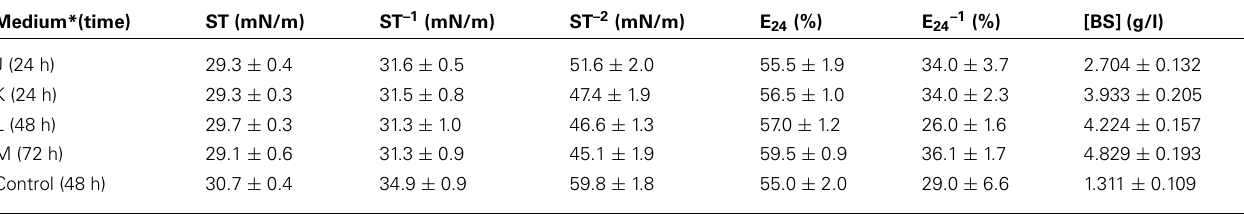
Table 5 | Surface tension values [ST, ST –1 , and ST –2 (mN/m)], emulsifying indexes [E 24 , E 24–1 (%)] and biosurfactant concentrations obtained in cultures performed with B. subtilis #573 grown in CSL 10% supplemented with different combinations of metals.